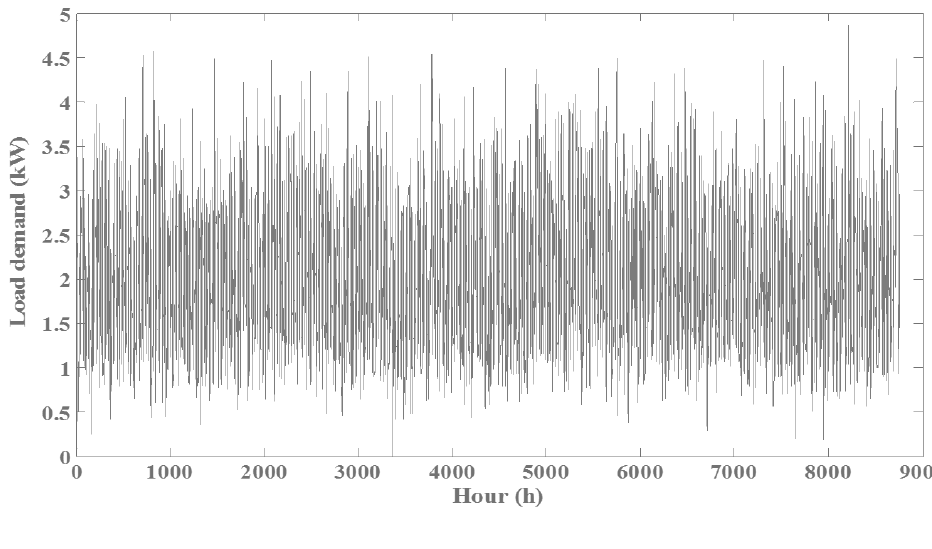
Figure 1. Characteristic of the Electric Charge in the Desired Area throughout the Year.